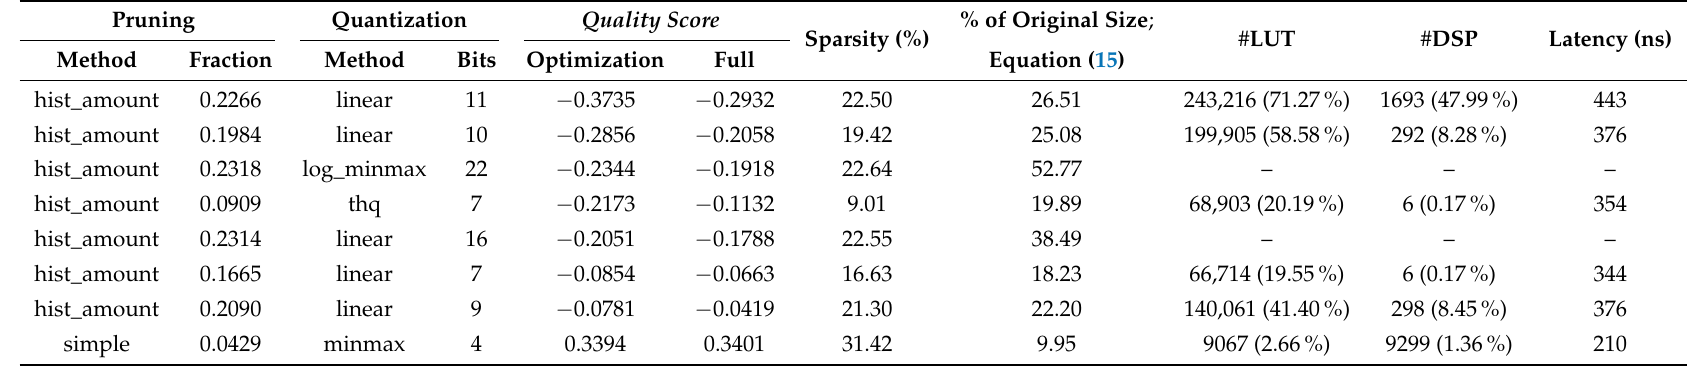
Table 6. [LHC] Results for a pruned and quantized model trained on bucketized data. Pauses indicate results, for which the resources consumption exceeded